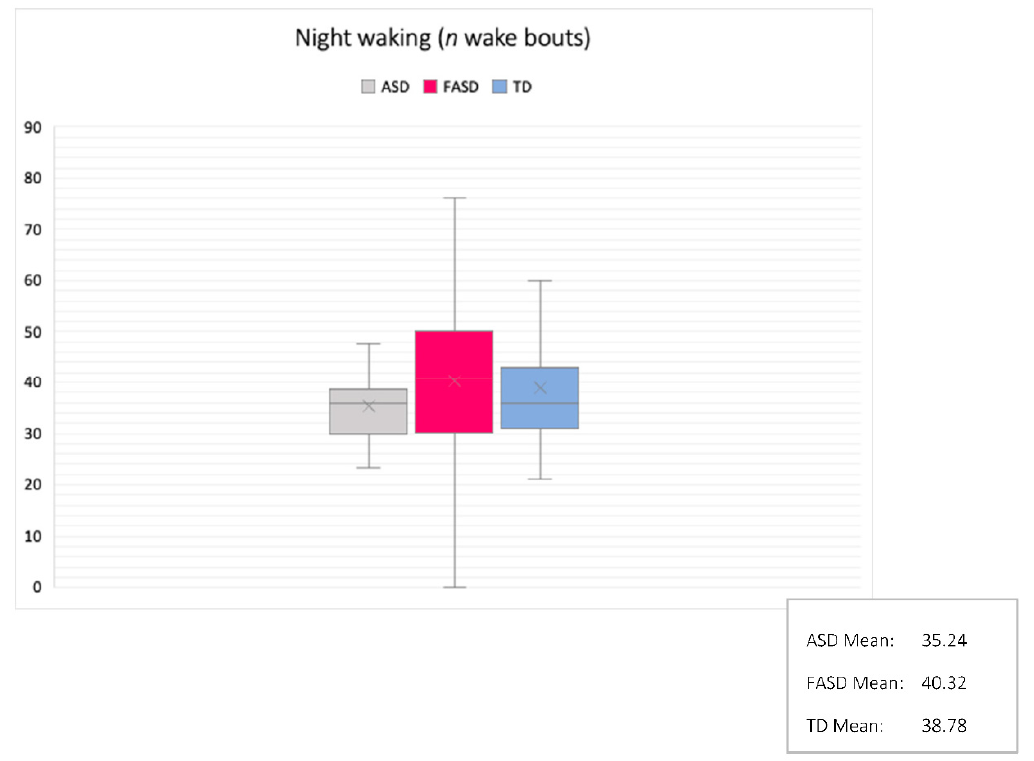
Figure 6. Mean night wakings (n): comparison between groups (M/SD shown).